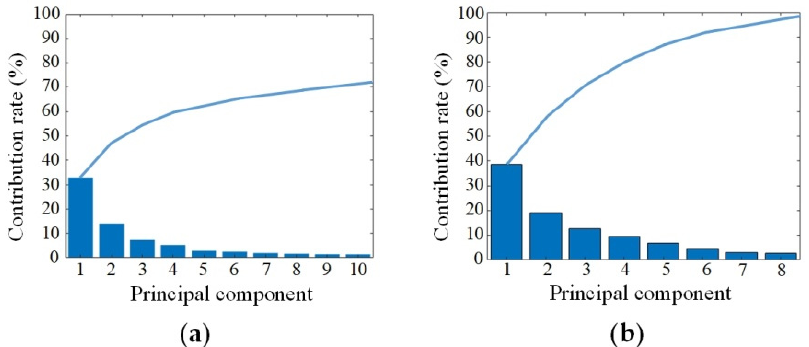
Figure 4. Principle component contribution rates with different dimensionality reduction methods. The columns represented the contribution rates of every principle component, and the lines represented the corresponding cumulative contribution rates. ( a ) PCA; ( b ) PLS.